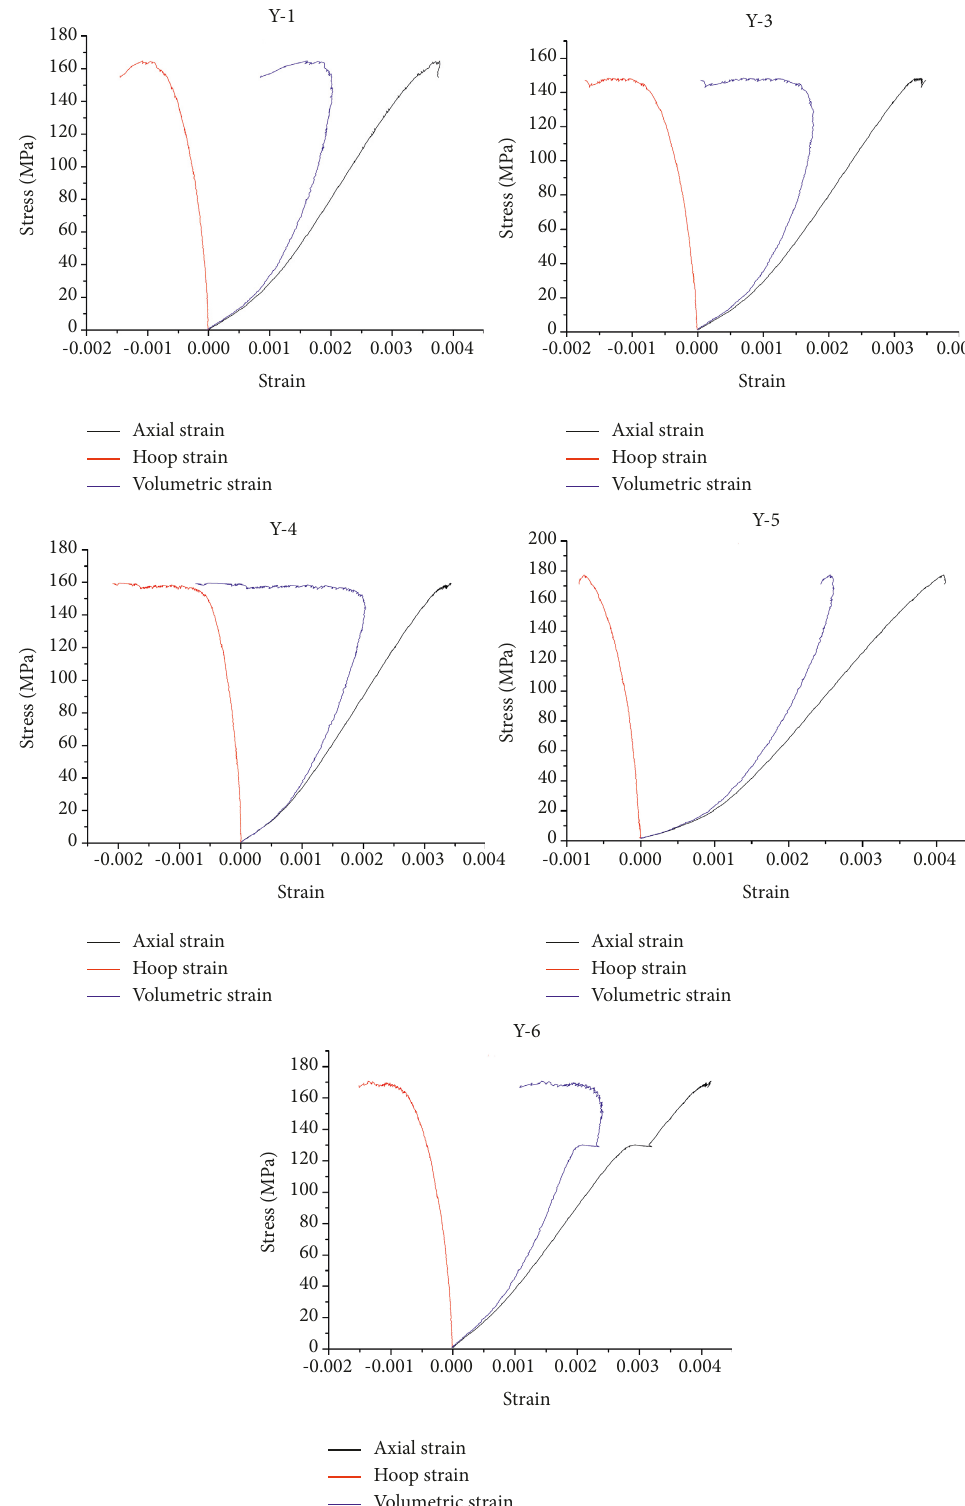
Figure 4: Stress-strain curve of